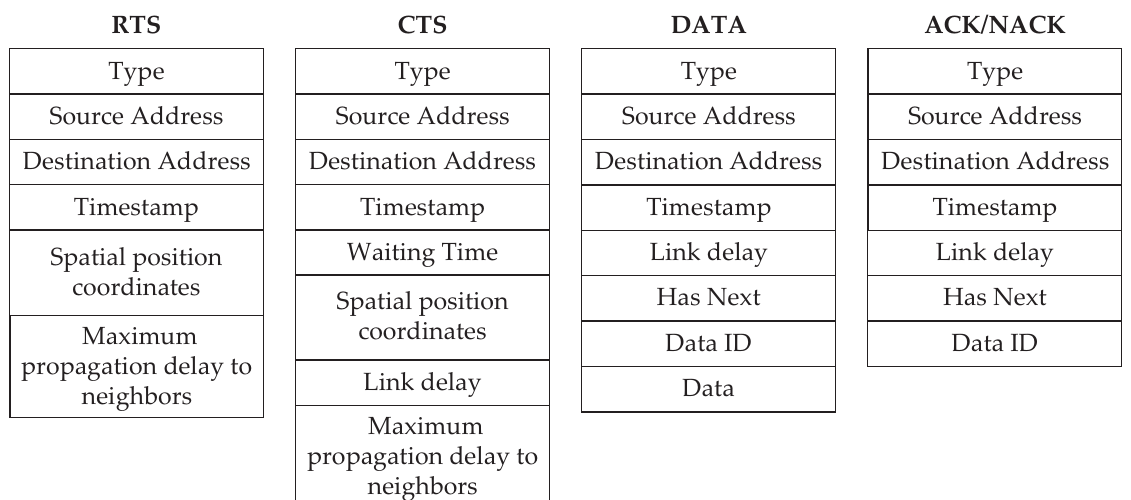
Figure 7. Packet structures of RTS, CTS, DATA, ACK, and